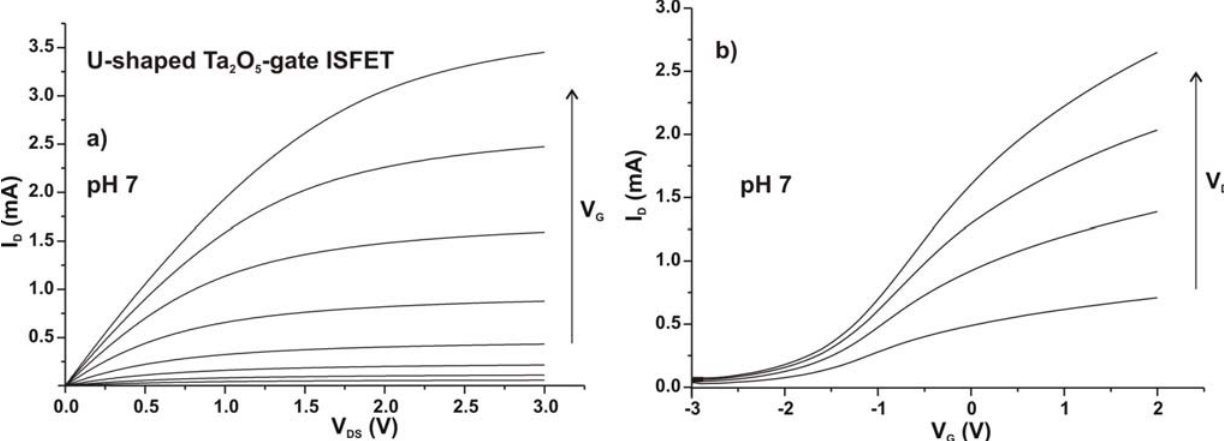
Figure 6. Output (a) and transfer (b) characteristics of an ISFET (layout (b) in Figure 5) measured on wafer level by means of the developed experimental set-up with the micro-droplet cell.